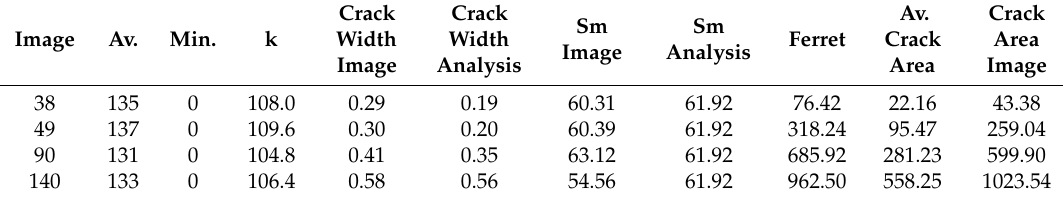
Table 3. Measured and calculated results for Specimen 3.